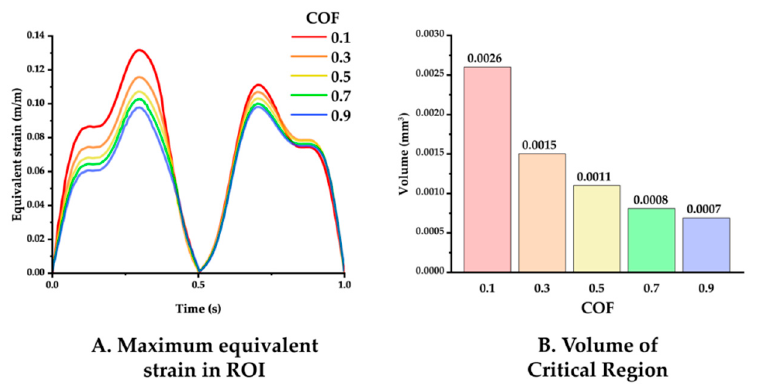
Figure 7. ( A ) Maximum equivalent strain variation versus time with varying COF: 0.1, 0.3, 0.5,